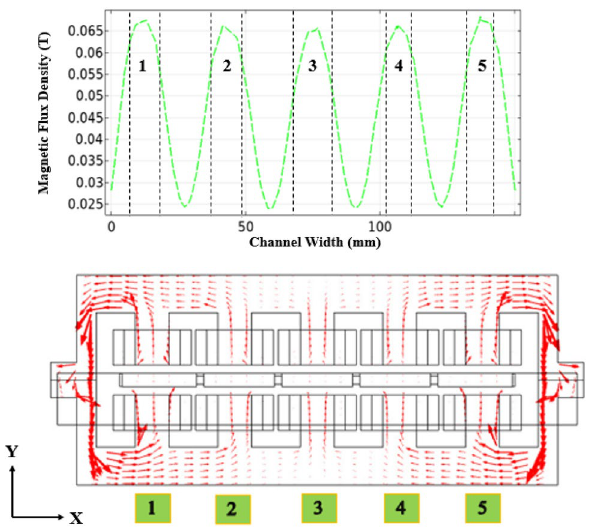
Fig. 17 The magnetic field lines and graph when all the arrays were active